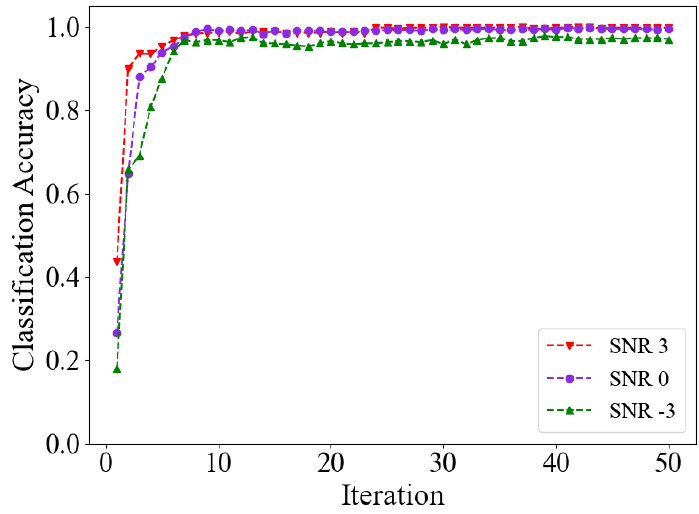
Figure 16. The results of model training on different noise levels (testing on DUT